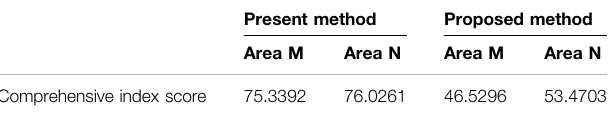
TABLE 6 | Comprehensive score of power grid planning based on different index systems. Present